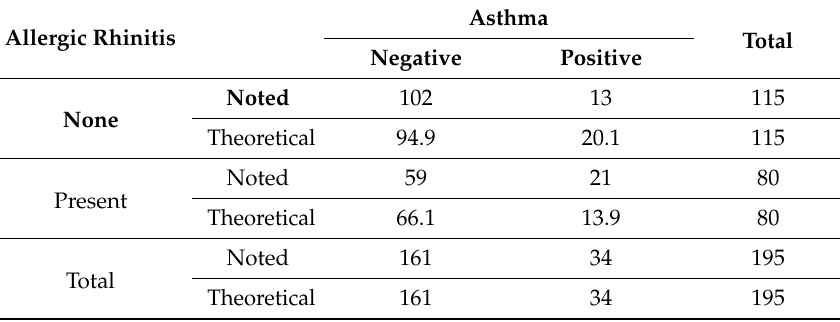
Table 9. Contingency table of the correlation between allergic rhinitis and